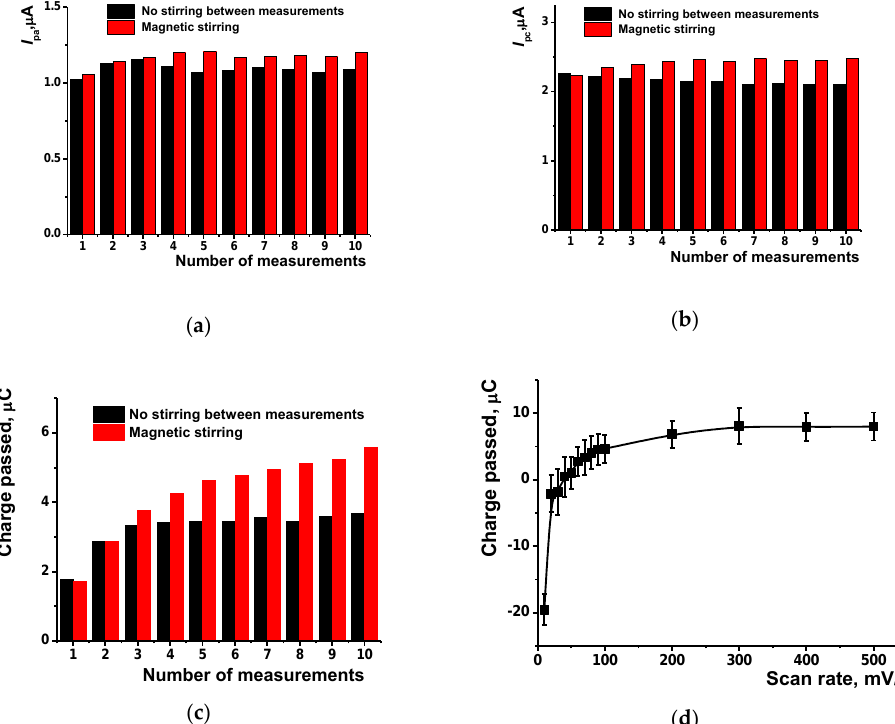
Figure 2. The dependency of cathodic ( a ), anodic ( b ) peak currents and charge passed ( c ) on the number of consecutive measurements separated by magnetic stirring of solution or by its equalization in open circuit mode. 0.025 M PB, pH = 7.0, scan rate 100 mV/s; ( d ) The dependence of the charge passed in the whole potential cycle between −0.4 and 0.8 V on the scan rate.